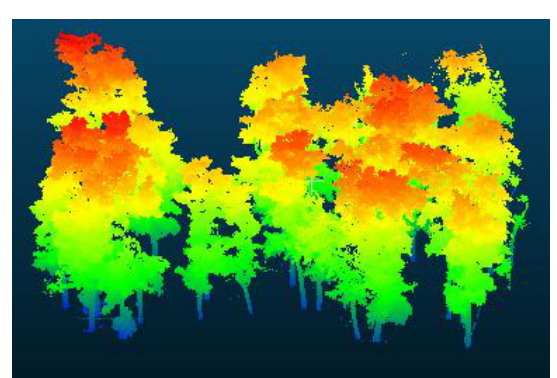
Figure 6.The test data of Yongding River